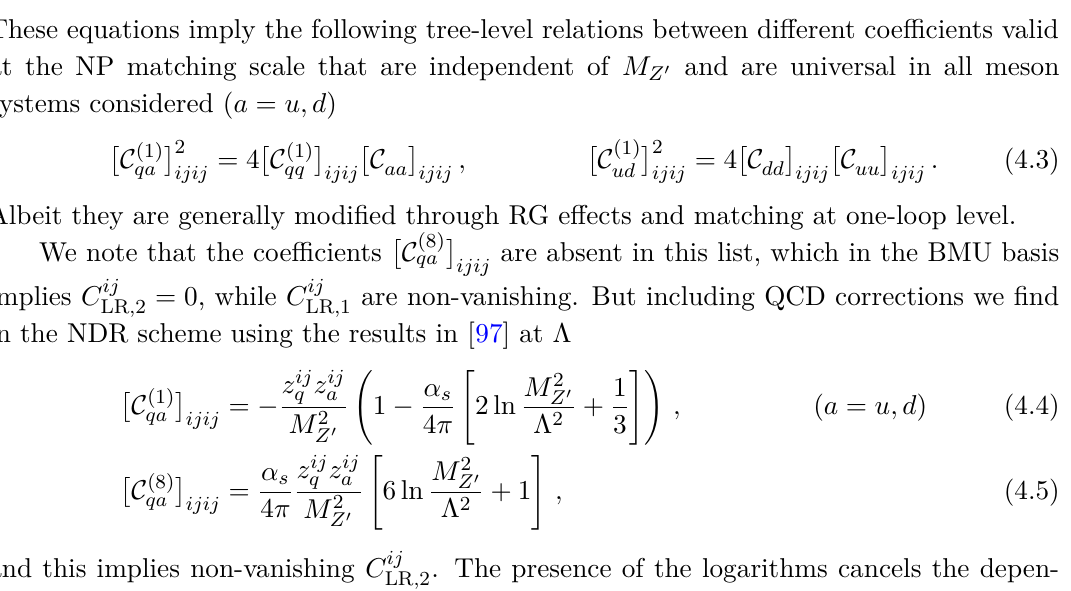
Figure 11 . The maximal NP scale Λ for (cid:2) (cid:3) M ij / (∆ M ij ) exp for B s (blue), B d (red) and K 0 (green), 2 12 BSM